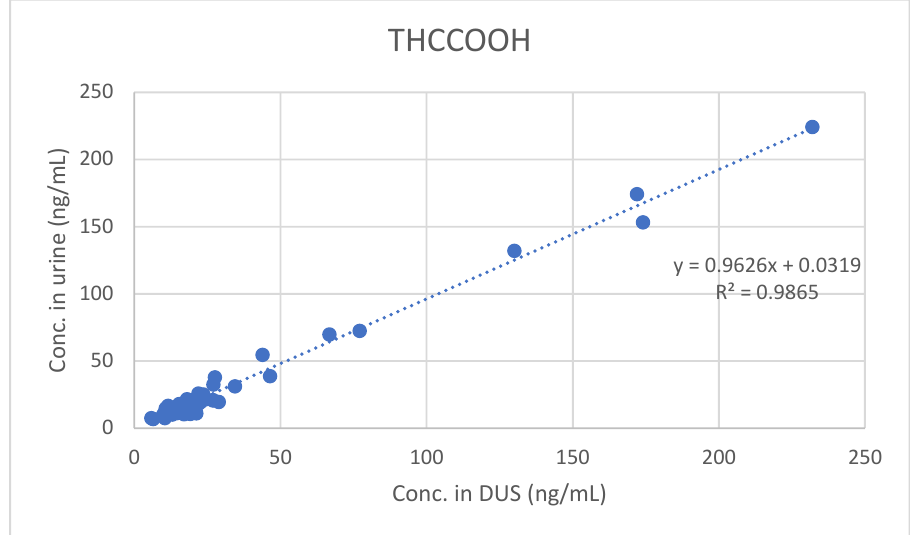
Figure 2. Comparison between urine and DUS concentrations of THCCOOH.